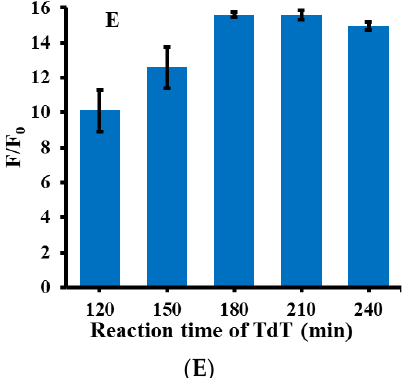
Figure 2. Optimization of the experimental conditions for the detection system of miRNA-21. ( A ) Concentrations of cDNA (20, 30, 40, 60, 80 nM); ( B ) Concentration of KF polymerase (50, 75, 100, 125, 150 U/mL); ( C ) Concentration of NtBstNBI (20, 30,40, 50, 60 U/mL); ( D ) Concentration of TdT (70, 140, 210, 280, 350 U/mL); ( E ) TdT reaction time (120, 150, 180, 210, 240 min). The concentration of the other reagents remained the same when each experimental condition was optimized.